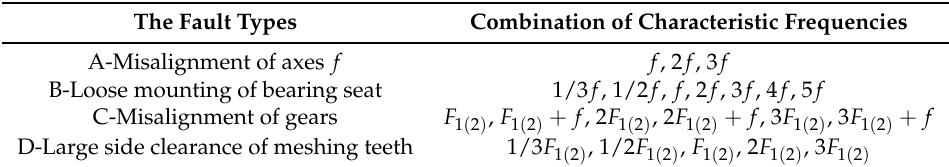
Table 4. Combinations of different fault characteristic frequencies.